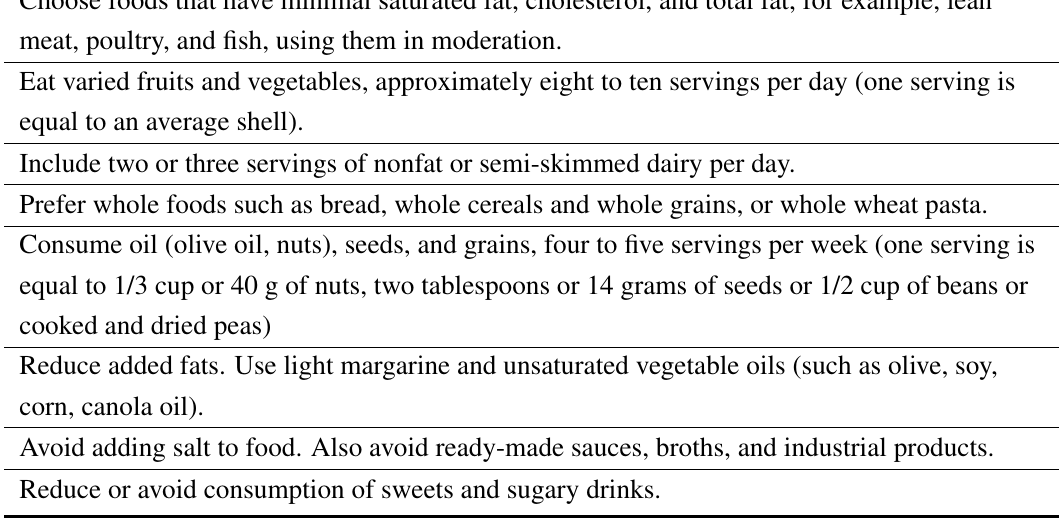
Table 9. Brazilian Cardiology Society Nutritional Recommendations for Hypertension.